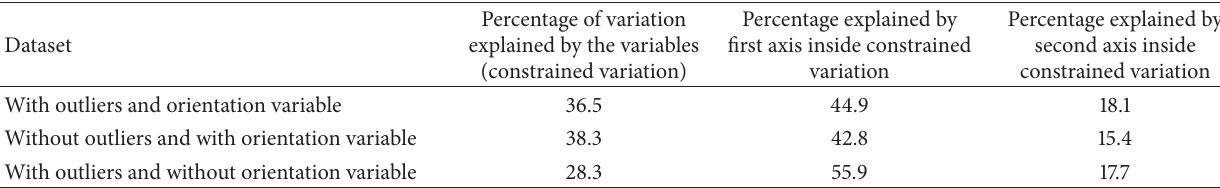
Table 2: Results of the tb-RDA